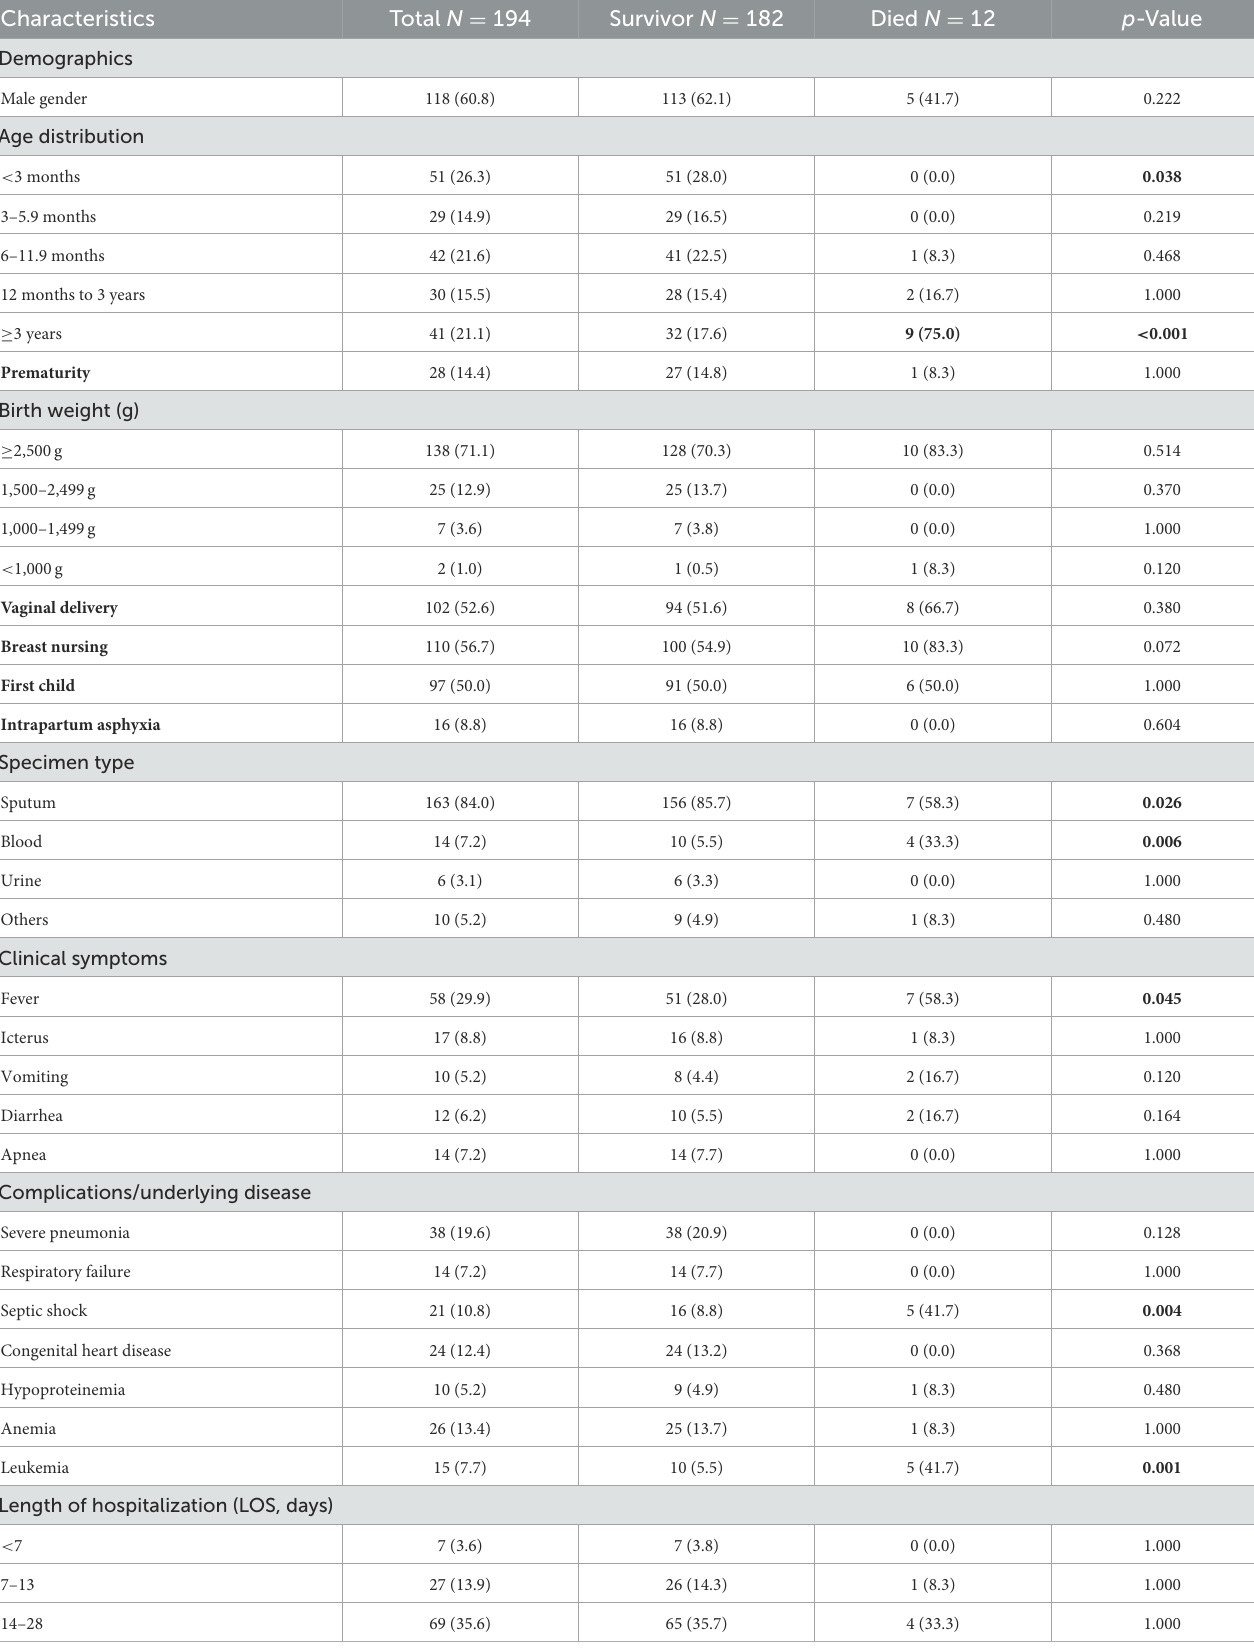
TABLE 4 Univariate analysis for factors associated with mortality of children with Pseudomonas aeruginosa infection.